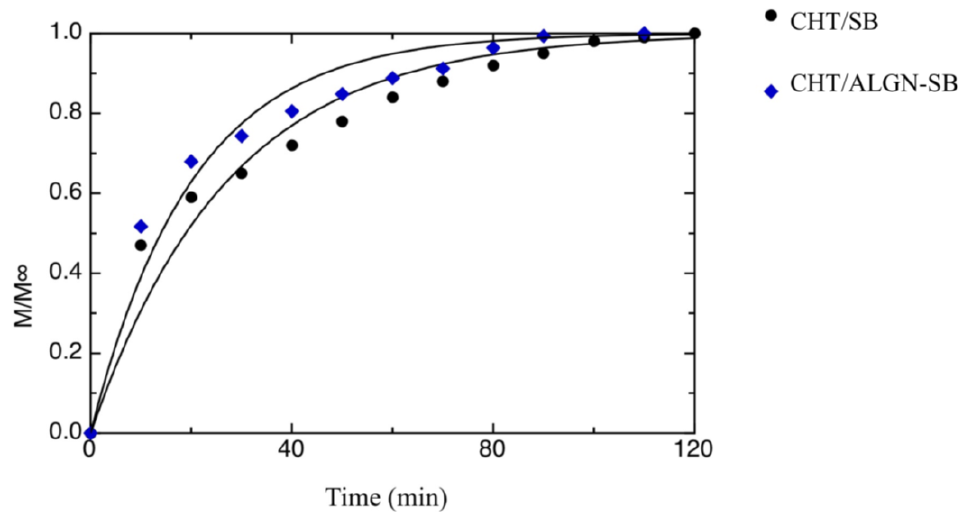
Figure 1. Release kinetics of sodium benzoate (SB) in water for both the CHT/SB and CHT/ALGN-SB films. The curves in the figure represent the best fitting to the data.